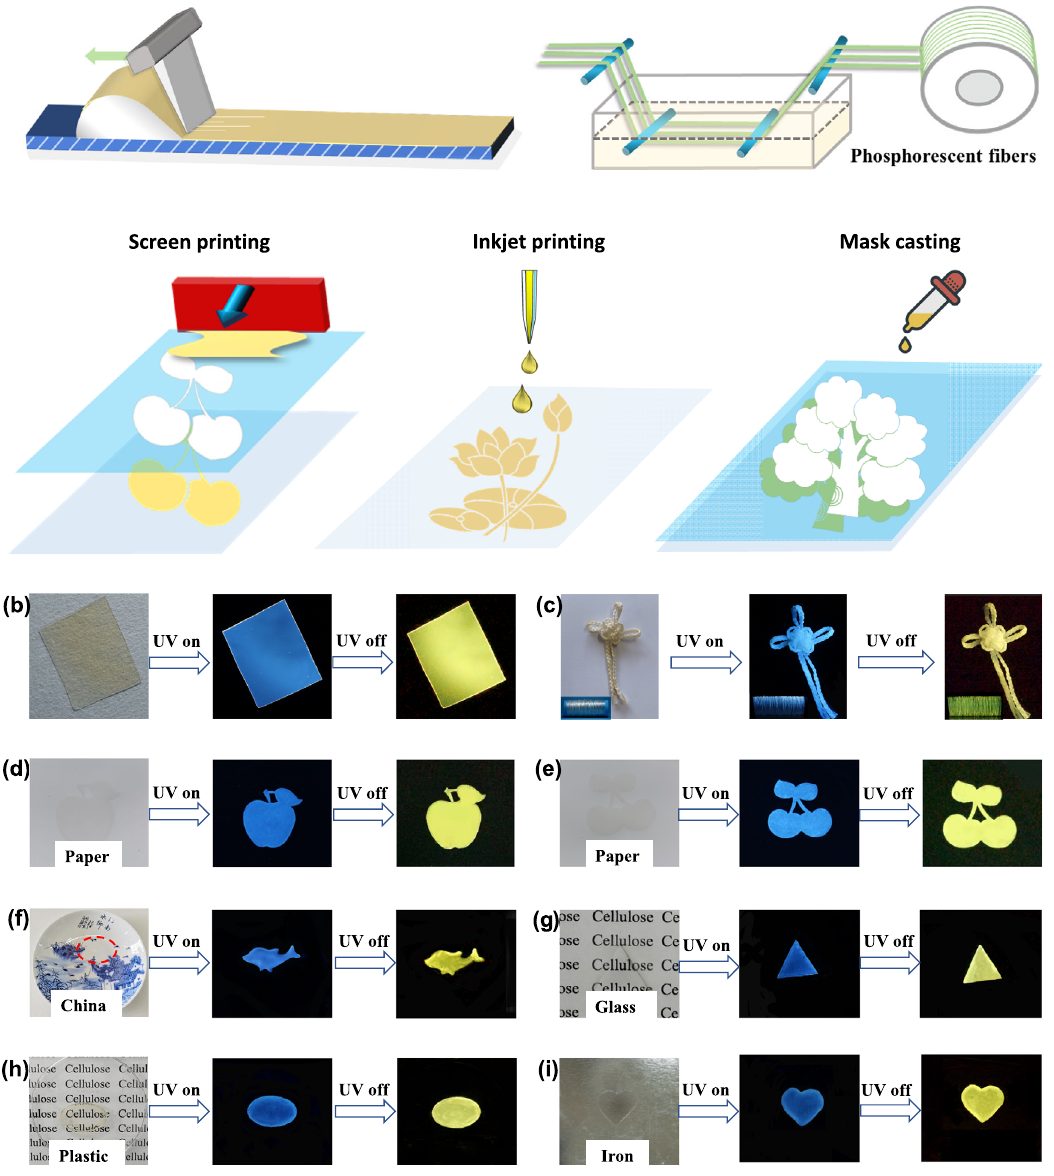
Fig. 4 Processability and formability of Cell-ImCNCl. a Processing methods of Cell-ImCNCl; b Phosphorescent Cell-ImCNCl fi lm made by the doctor blade coating method; c Phosphorescent “ Chinese knot ” from PVA fi bers produced by the dip coating method; d – i Phosphorescent patterns on various substrates. The ultraviolet light used is 365